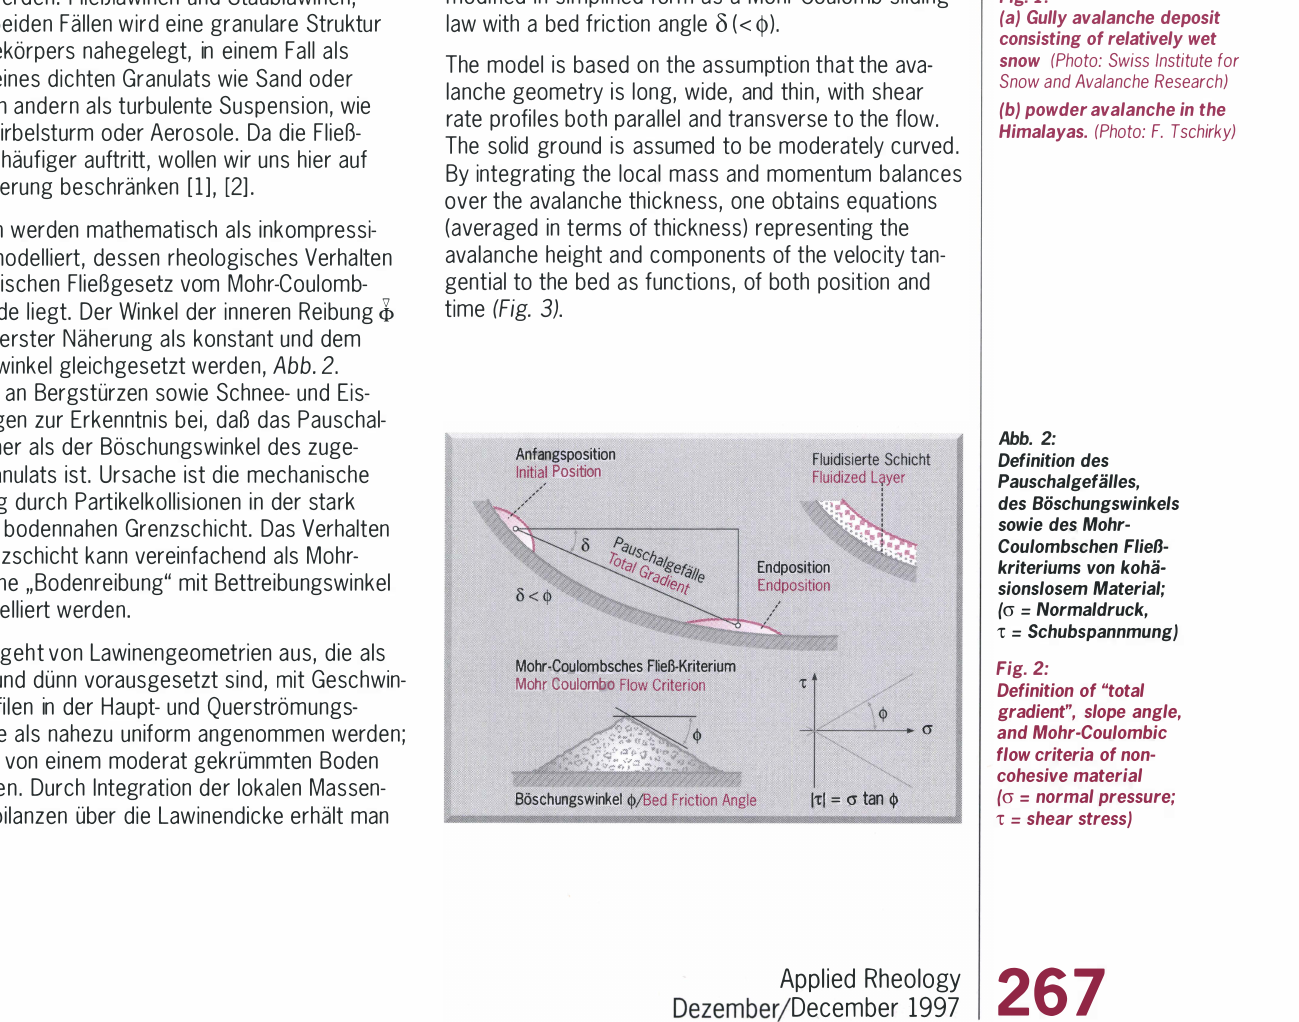
Fig.l: (a) Gully avalanche deposit consisting of relatively wet snow (Photo: Swiss Institute for Snow and Avalanche Research) (b) powder avalanche in the Himalayas. (Photo: F. Tschirky)